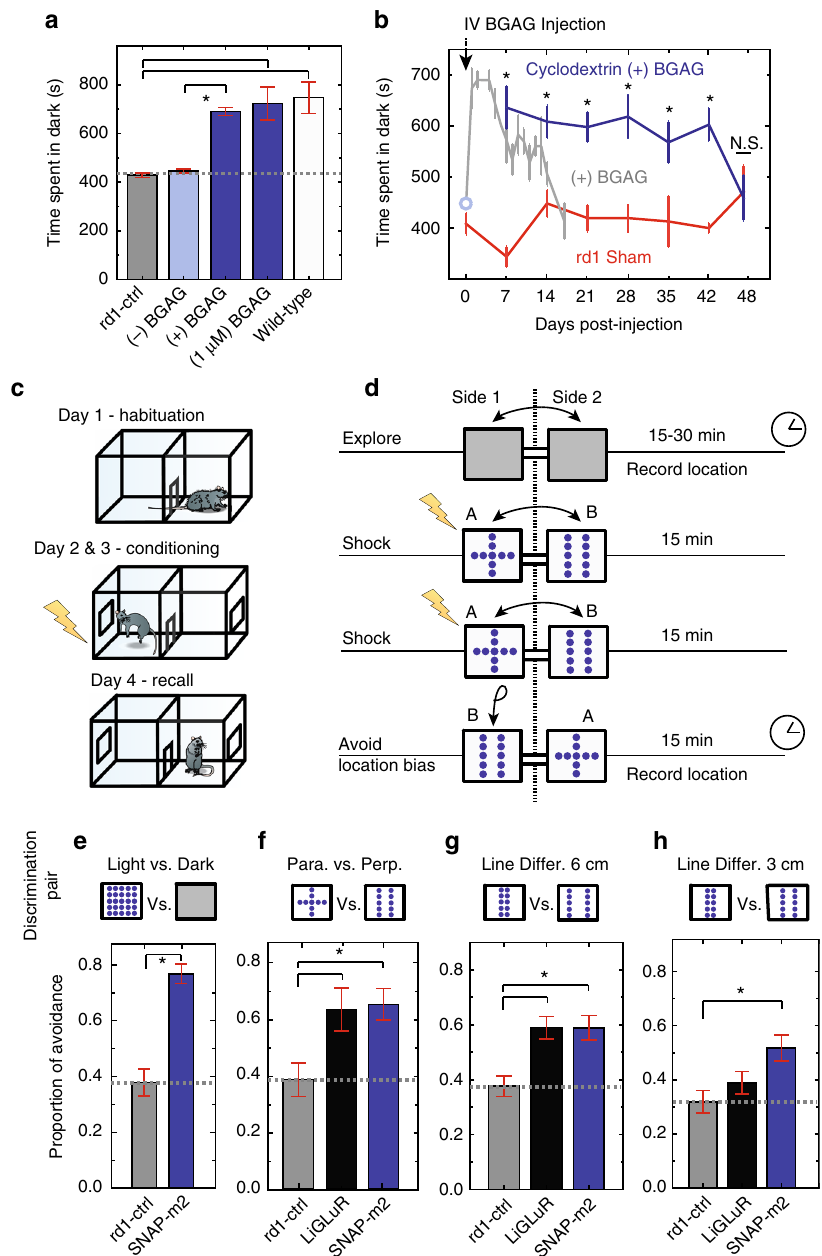
Fig. 3 Light avoidance and learned visually guided behavior in rd1 mouse expressing SNAG-mGluR2. a Restoration of light avoidance behavior. rd1 mice ( n = 7) and rd1 mice expressing SNAP-mGluR2 spend equal times in dark and light compartments (grey dotted line) before delivery of BGAG 12,460 ( – BGAG) but prefer the dark compartment after intravitreal injection of BGAG 12,460 ( + BGAG) ( n = 7) to a similar level to wild-type mice ( n = 7) and to mice treated with 500x lower photoswitch ( n = 8). b Restored light avoidance persists 2 weeks after single injection of 1 mM BGAG 12,460 (gray) ( n = 7). When 3uM BGAG 12,460 is combined with beta cyclodextrin in PBS as a method slow release drug delivery, light avoidance persists for 42 days (one-way ANOVA p < 0.005) with no decline in performance (blue) until day 48 ( n = 11) (rANOVA p = 0.401). Rd1 sham injected mice were assessed over the same 48-day period (red) ( n = 8) (Supplementary Table 2). c , d Schematic of pattern discrimination experiment. Mice habituated at day 1, exposed to electric shock in association with speci fi c pattern of light (stimulus A/B) paired randomly in either chamber on days 2 and 3 and tested (time spent in each chamber) on day 4, in absence of shock with light patterns reversed to avoid location bias. e Learned dark avoidance behavior. Proportion of time spent avoiding the dark after paired conditioning with shock. rd1 SNAG-mGluR2 ( n = 6), rd1 control ( n = 6). Values mean ± SEM f – h Learned pattern discrimination. Proportion of time spent avoiding pattern paired with shock. f Perpendicular vs. parallel bars. g , h Discrimination of parallel bars at distances of 1 vs. 6 cm ( g ) or 1 vs. 3 cm ( h ). Respectively for f , g and h : rd1 control ( n = 7, 13, 12 mice), rd1 LiGluR ( n = 7, 14, 15 mice), rd1 SNAG-mGluR2 ( n = 7, 10, 18 mice). In addition, proportion of success was also calculated (Supplementary Fig. 5b, d – g and Supplementary Table 3). All animals received 2 μ L intravitreal injection of 1 μ M BGAG 12,460 in each eye and assayed following 24 h recovery. Display of 472 nm light equaled 5 mW cm − 2 at decision point. n = # of mice. Statistical signi fi cance was assessed using repeated-measures ANOVA ( b ), one-way ANOVA: * p < 0.005 ( b ) (Supplementary Table 2), and Student ’ s two-tailed t -test with Bonferroni correction: * p <